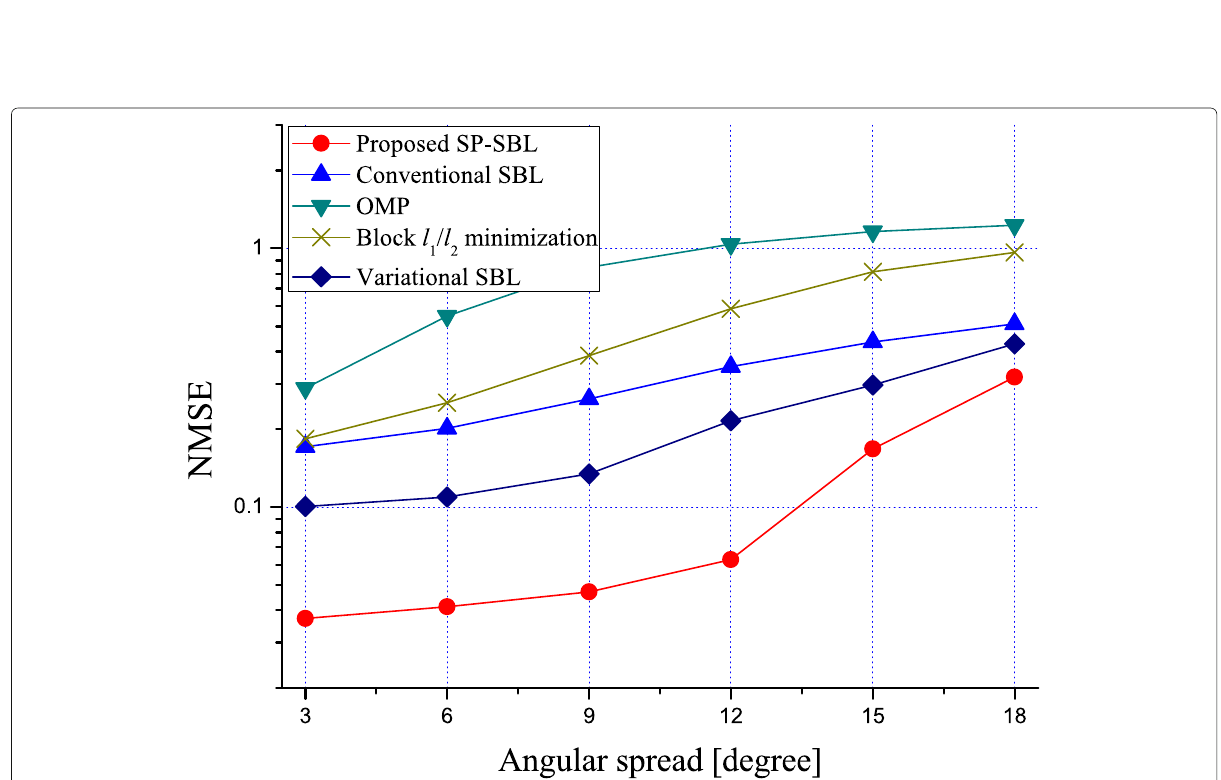
Fig. 6 NMSE performance for different angular spreads (cid:3) d , where N = 64 and M = 4. The length of pilot sequence is T = 16 and the transmit SNR = 15 of BS is NP σ 2